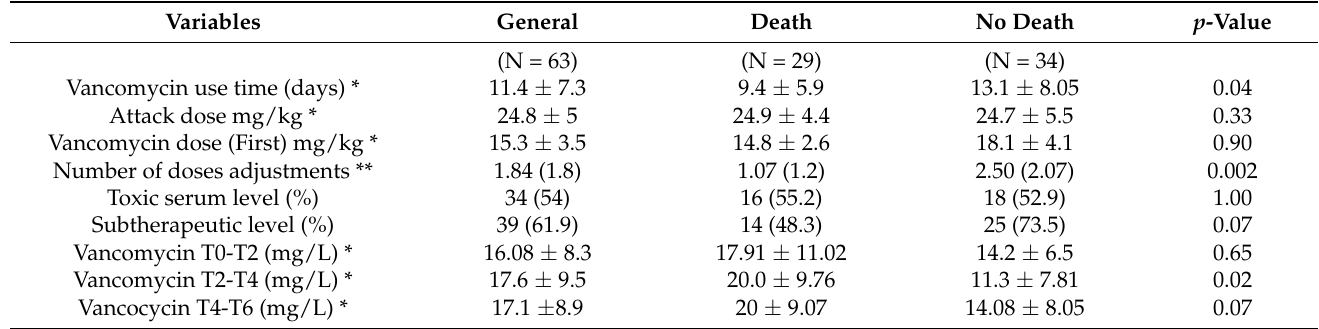
Table 5. Features related to vancomycin in patients hospitalized in an intensive care unit, compared to its